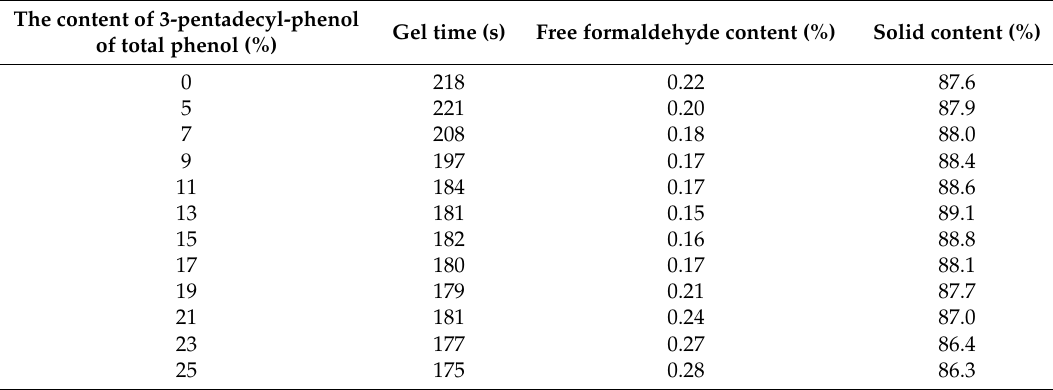
Table 2. The basic properties of the resin.